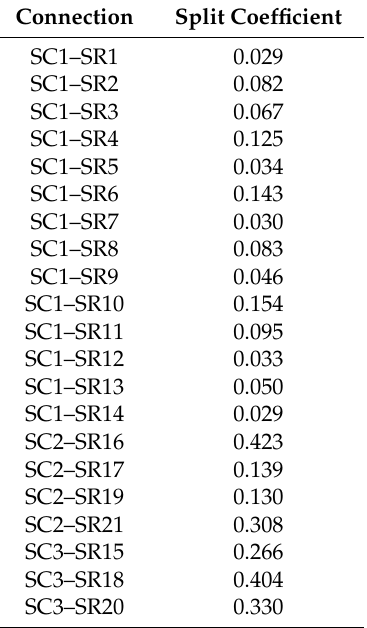
Figure 10. ( a ) Annual population-increase rate derived for the Emilia-Romagna Region [32]; (b) LAs served by the UWS, correspondent inhabitants and water demand based on indoor consumption. Table 6. Split coefficients between SCs and SRs, i.e., the served LAs directly linked.